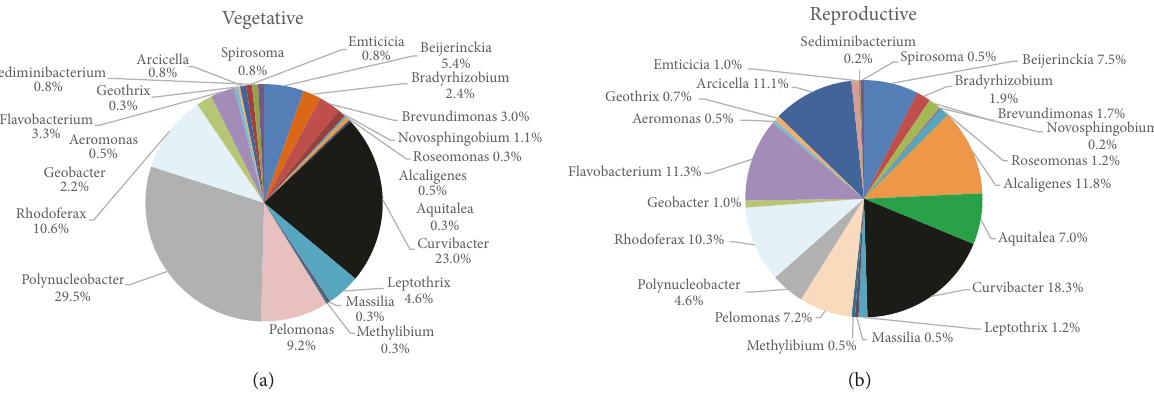
Figure 6: Relative abundances of genus level assignments for the OTUs shared between vegetative stage (a) and reproductive stage